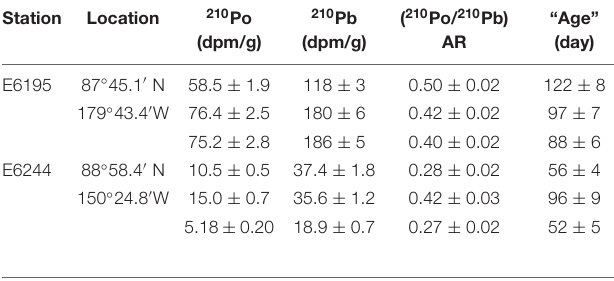
TABLE 4 | Activities + of excess 210 Po, 210 Pb, 210 Po/ 210 Pb AR and age of ice-rafted